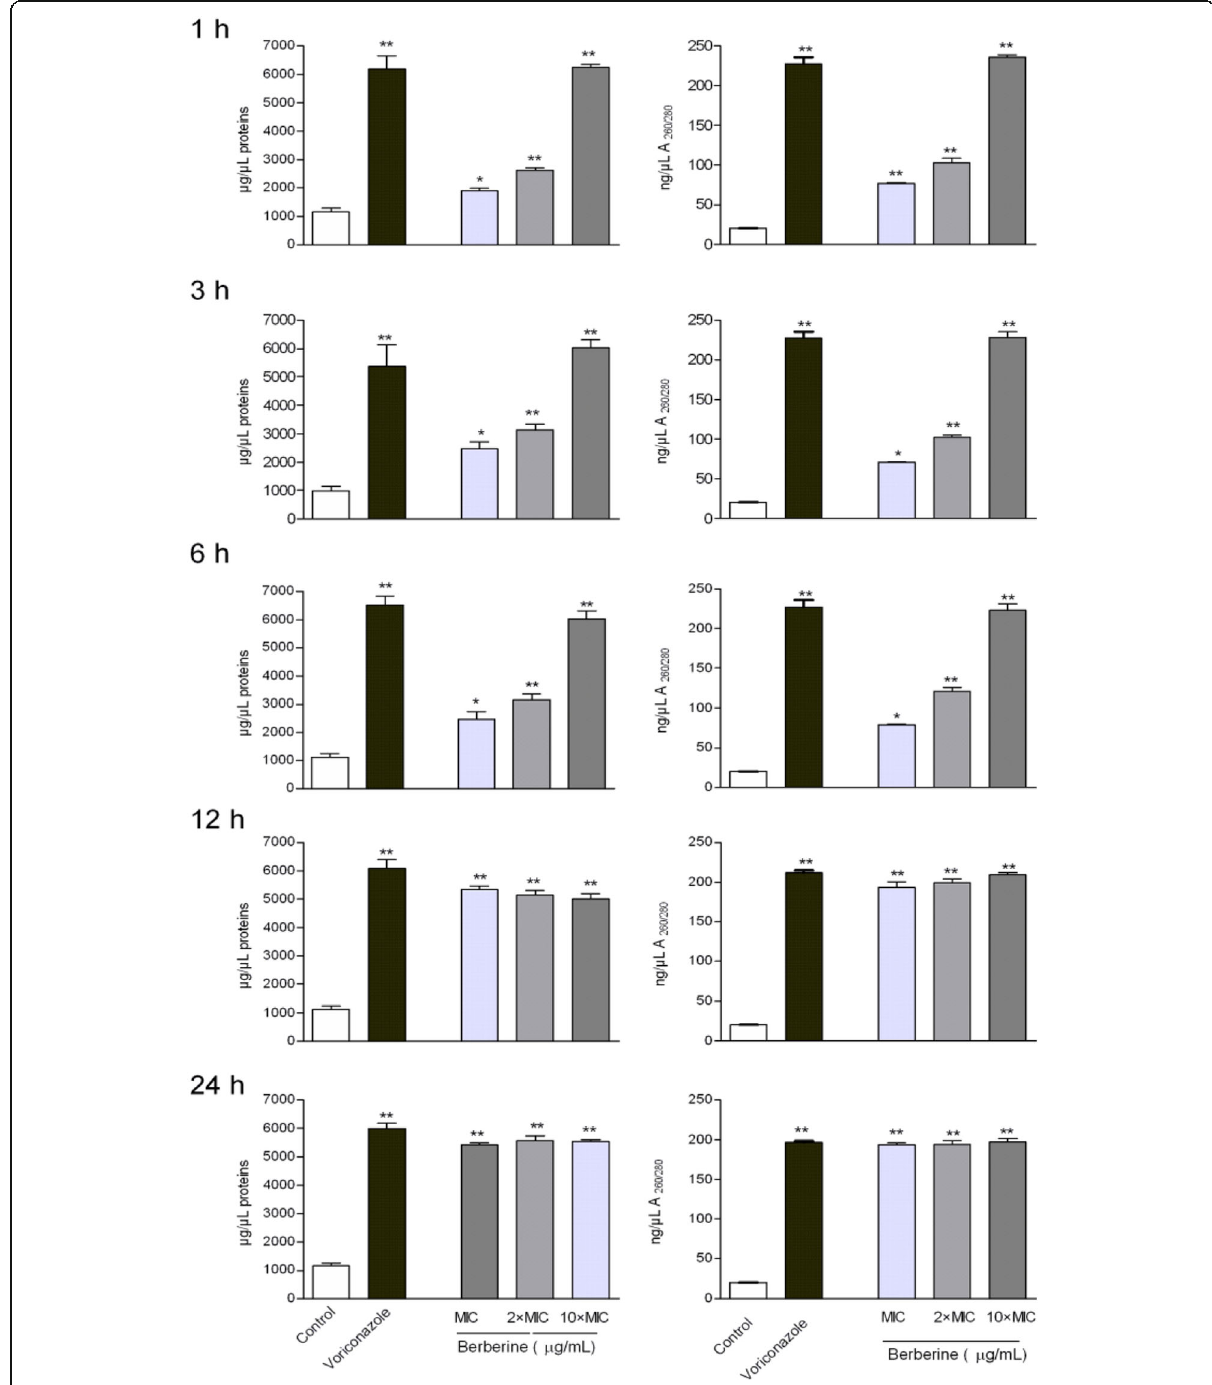
Fig. 5 The effect of berberine on cell permeability and integrity of cell membranes of C. albicans cells. The data are shown as means ±